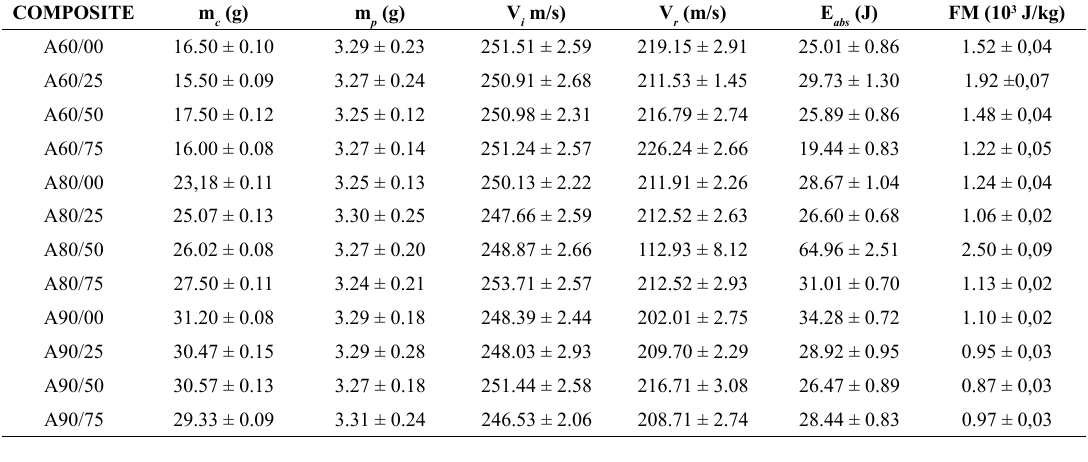
Table 1. Average results of the ballistic tests.